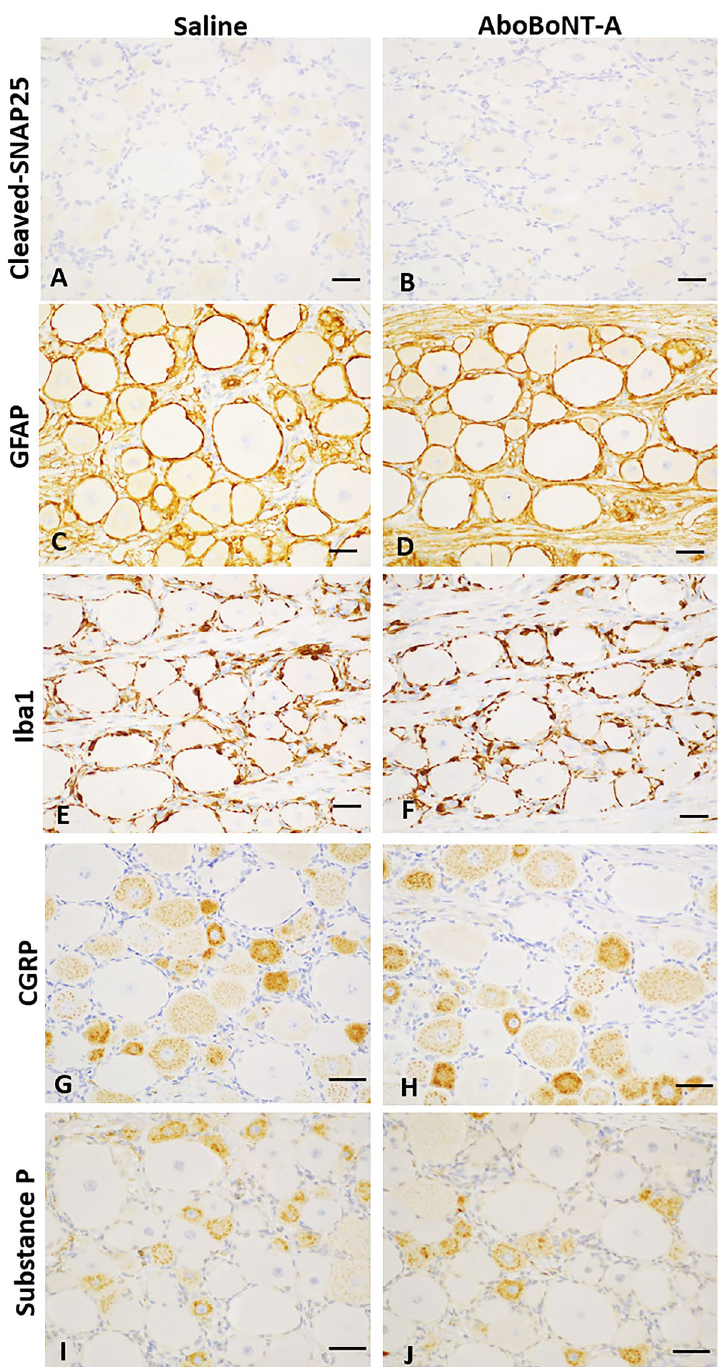
Figure 8. Cleaved SNAP25, GFAP, Iba1, CGRP, and SP immunolabelling in the DRGs of saline- and aboBoNT- A-treated animals. Photomicrographs are taken from DRGs located on L5-L6 sections of the lumbar spinal cord ipsilateral to the incision in representative animals that received a full-skin and muscle incision and retraction surgery (Day 0), followed by intraoperative treatment with either saline ( A, C, E, G, I ) or 400 U aboBoNT-A ( B, D, F, H, J ) and tissue collection on Day 6. Scale bars: 50 µm. GFAP, glial fibrillary acidic protein; CGRP, calcitonin gene-related peptide; SP, Substance P; Iba1, ionized calcium-binding adaptor protein-1; AboBoNT-A, abobotulinumtoxinA; U,